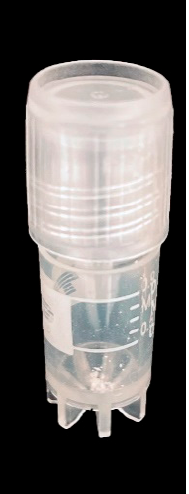
Figure 1. The preprepared cryovial containing a pharmacological grade high-molecular-weight HA (HMW-HA; >1.0 MDa).